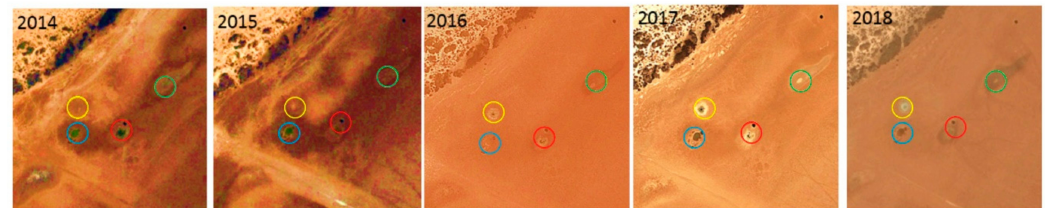
Figure 15. Monitoring of four salt cavities denoted by the yellow, green, blue, and red circles from 2014 to